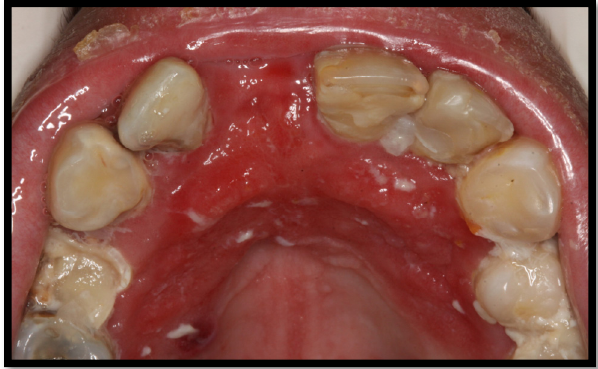
Figure 2. Erythematous candidiasis on the hard palate.